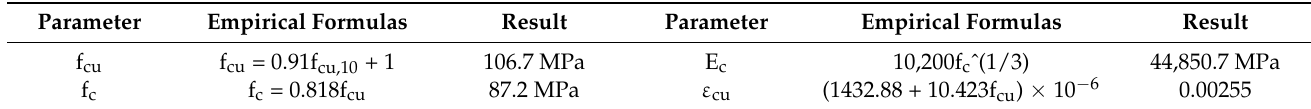
Table 2. Mechanical properties of Concrete using Empirical